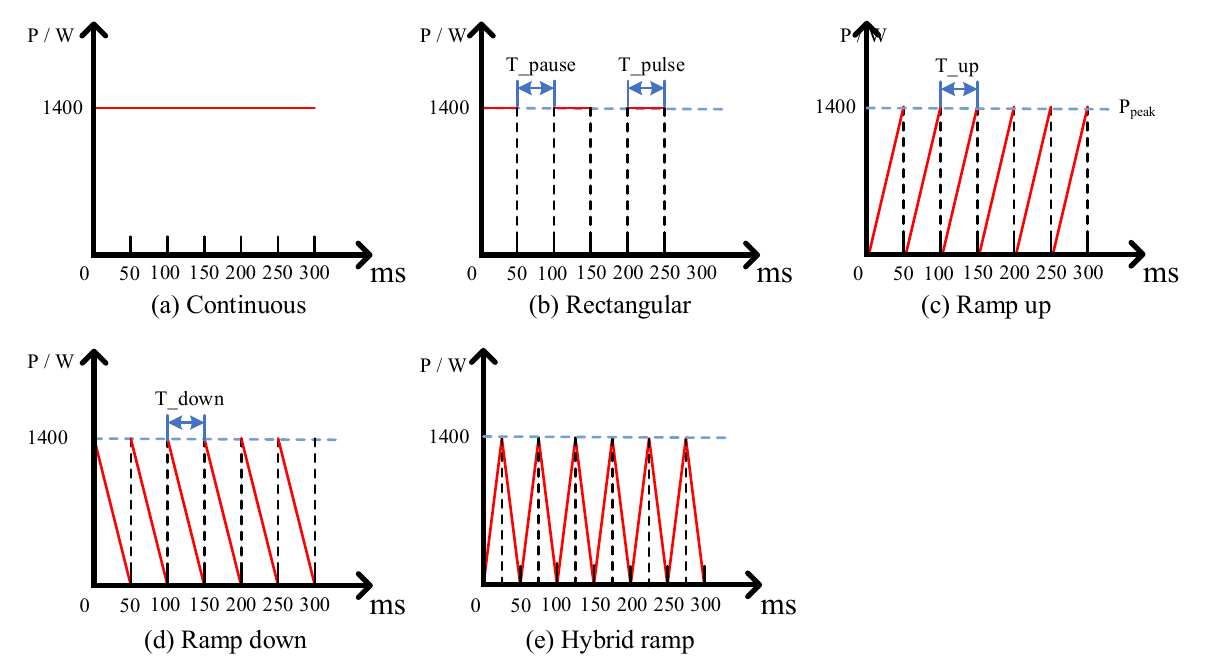
Figure 2. Schematic illustration of the five types of laser shape: ( a ) continuous, ( b ) rectangular, ( c ) ramp up, ( d ) ramp down, and ( e ) hybrid ramp laser shape. Table 2. Process parameters for experiments.